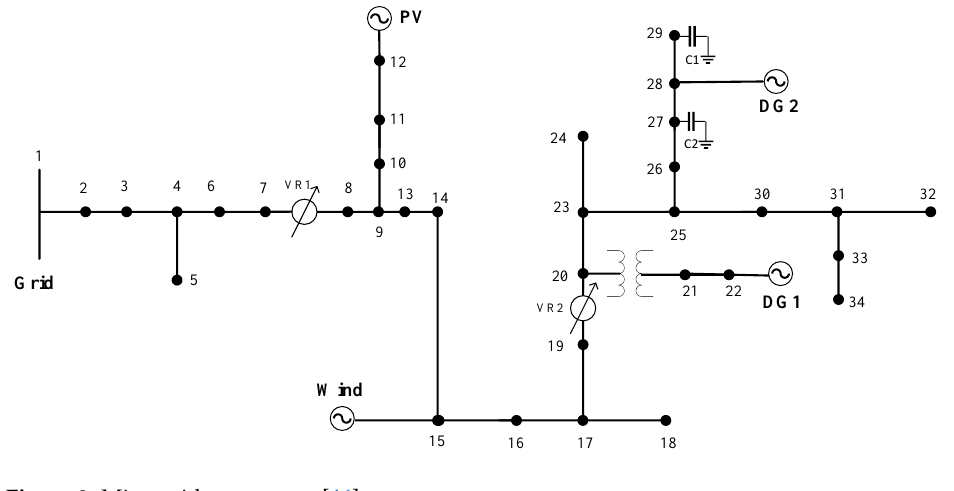
Figure 3. Microgrid test system [46]. Table 1. Generation characteristics of the two